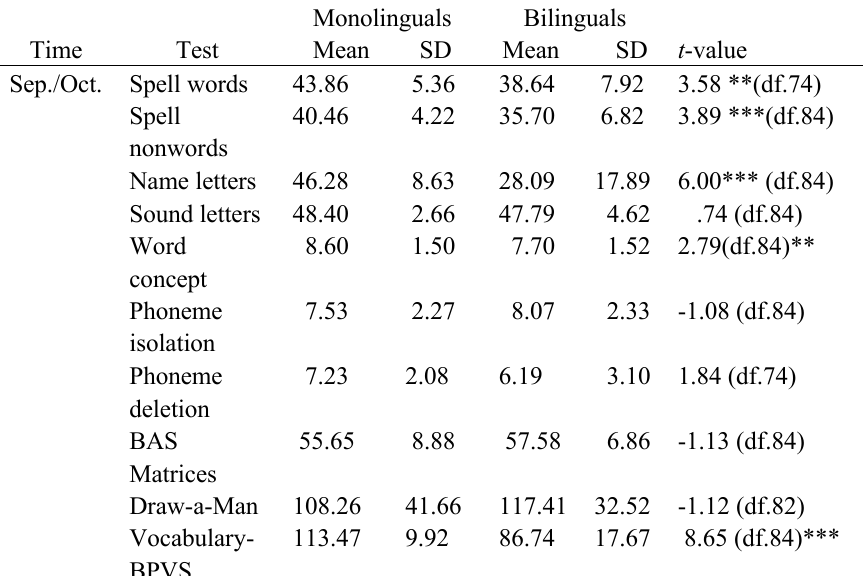
Table 2. Comparative data for monolinguals and bilinguals on all measures at all testing times Time